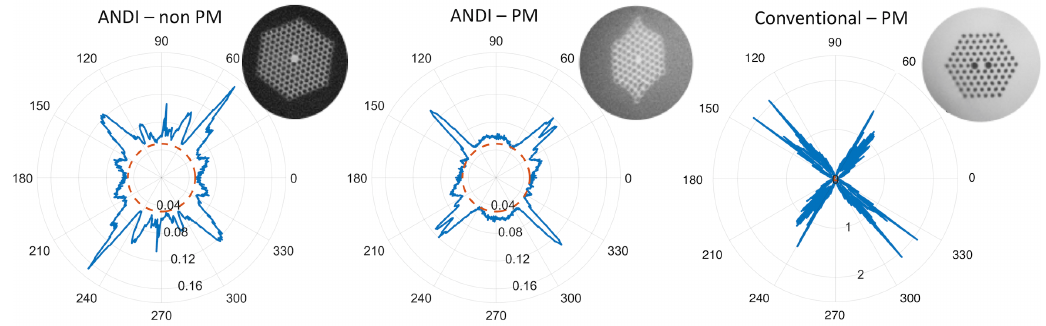
Fig. 1: Polarization-dependent RIN measurements of SC generated in ANDI PM and non-PM fiber as well as in a commercial conventional nonlinear PM fiber pumped in the anomalous dispersion regime (NKT PM-1550-01). The polar plot shows the polarization angle of the pump pulses with respect to the principal fiber axes, the RIN values are integrated from 0-18 MHz and given in percent. The red-dotted line shows the RIN of the pump